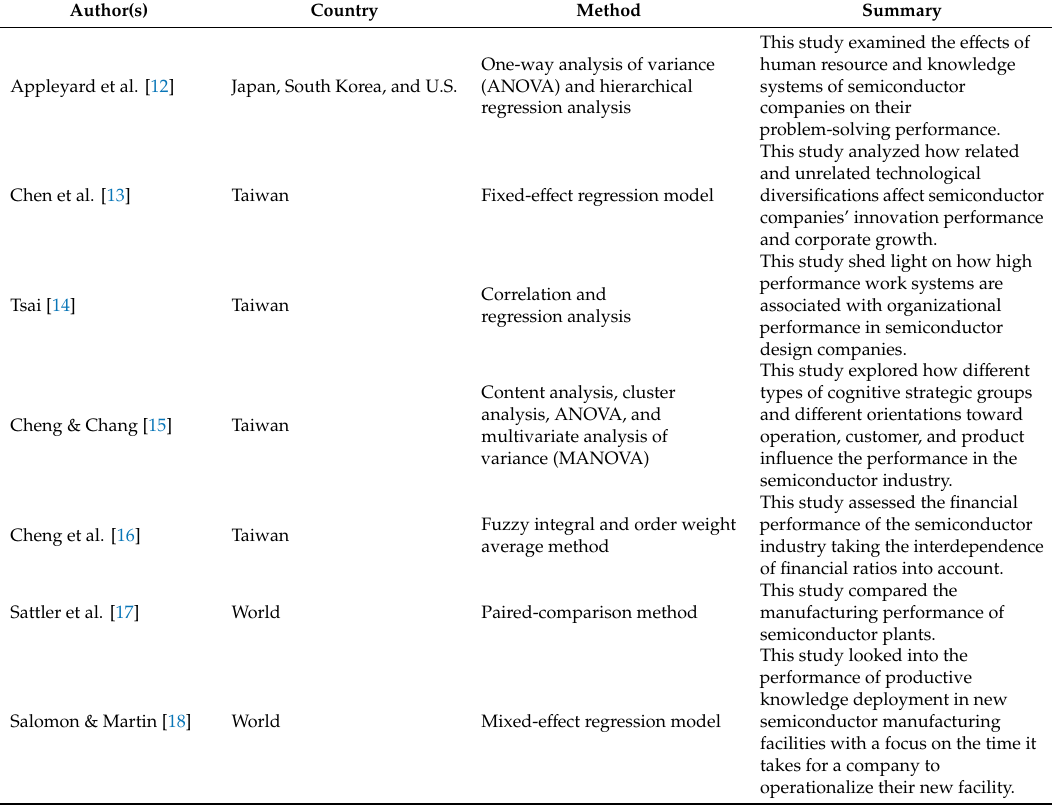
Table 1. Studies related to performance assessment of semiconductor industry.